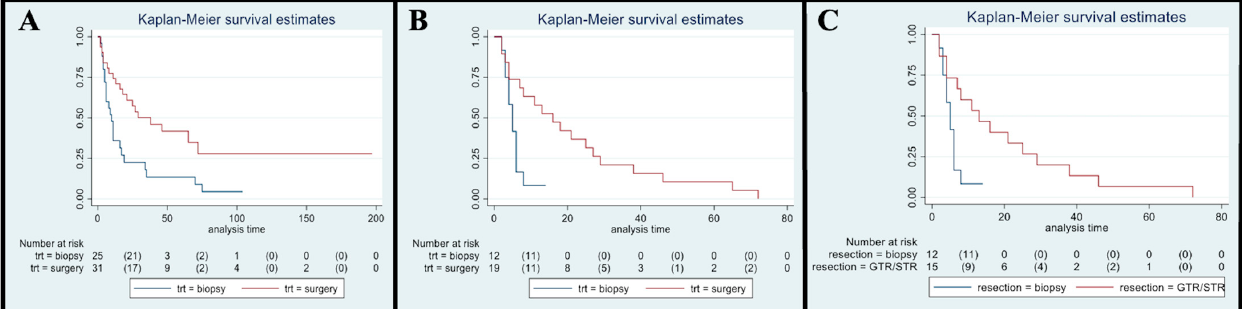
Figure 2. Kaplan–Meyer curves. ( A ). OS in all patients comparing surgery and biopsy. ( B ). Univariate analysis in the HGG subgroup. ( C ). OS considering the extent of resection in the HGG sub-group.